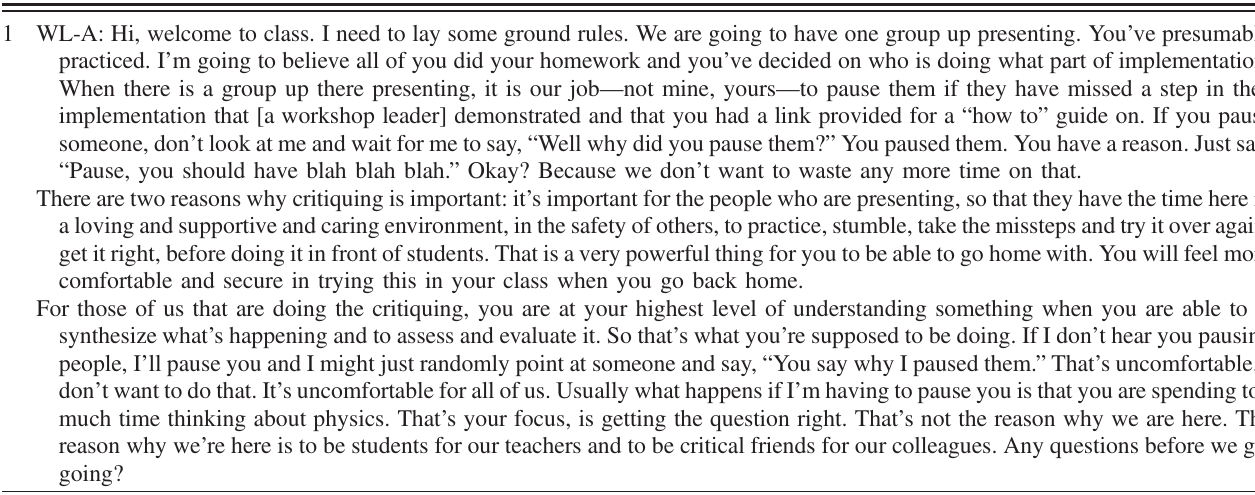
TABLE VIII. Transcript of WL-A ’ s initial framing of the TPS implementation session, i.e., the first few minutes of Session A. 1 WL-A: Hi, welcome to class. I need to lay some ground rules. We are going to have one group up presenting. You ’ ve